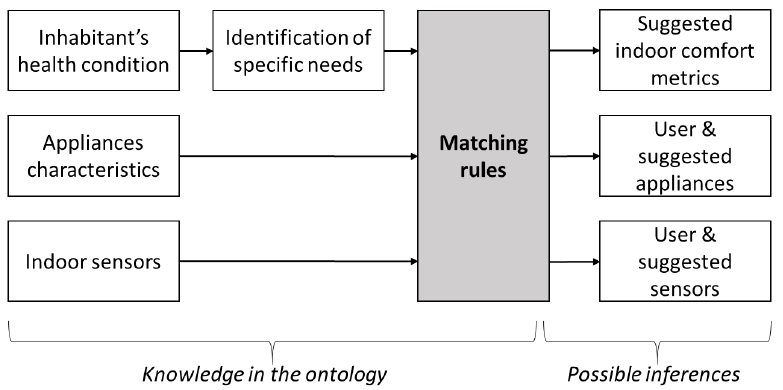
Figure 2. A schema representing the knowledge to be formalized in the Case 1 ontology and a list of expected outputs. Selecting the methodology. The OEM selected for developing the ontology